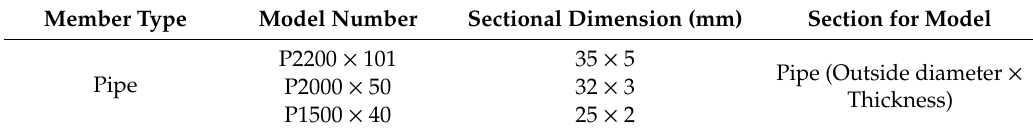
Table 3. Geometric dimension parameters of the jacket structure